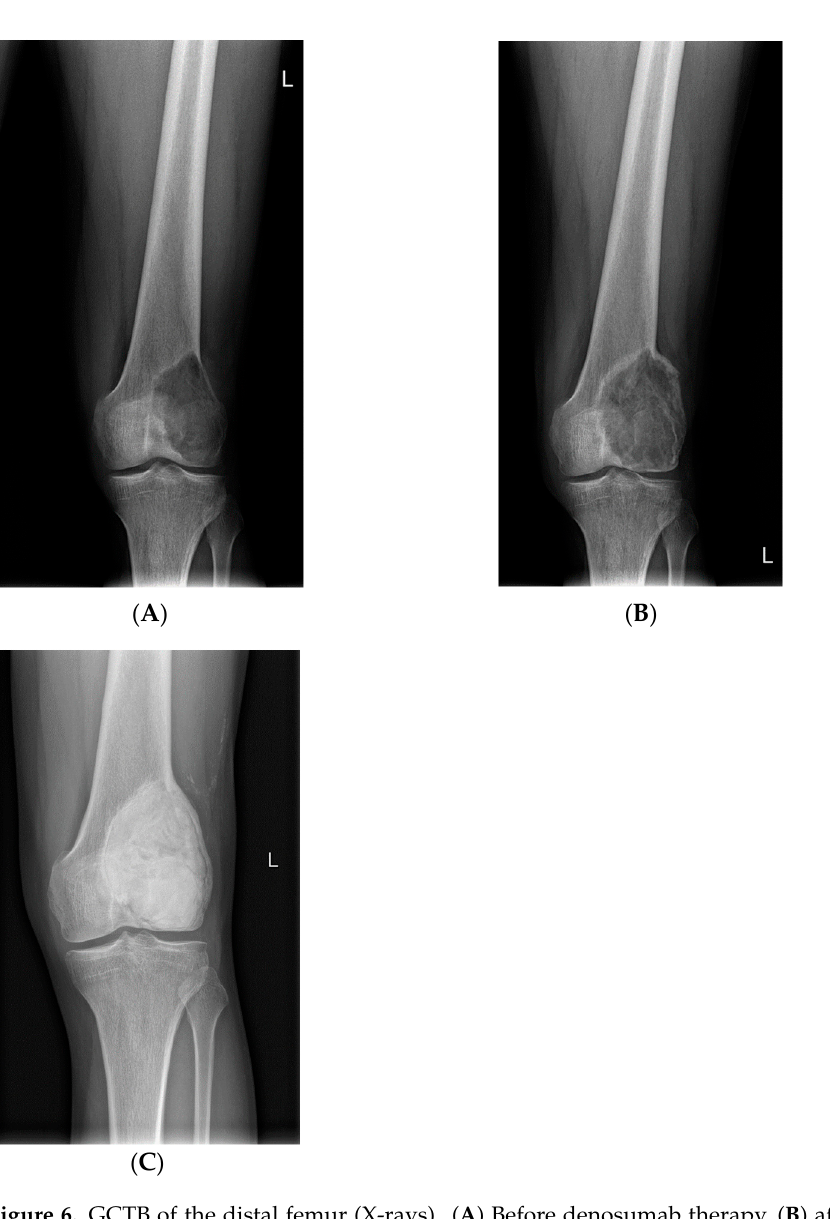
Figure 5. Response to denosumab therapy and radical resection of the GCTB of the second metacarpal followed by reconstruction with a 3D ‐ printed patient ‐ specific implant. ( A ) GCTB of the second metacarpal at the beginning of therapy; ( B ) X ‐ ray taken after 13 doses of denosumab treatment; ( C ) Intraoperative image showing well ‐ calcified tumor after dissection of surrounding soft tissue envelope; ( D ) 3D ‐ printed patient ‐ specific implant.